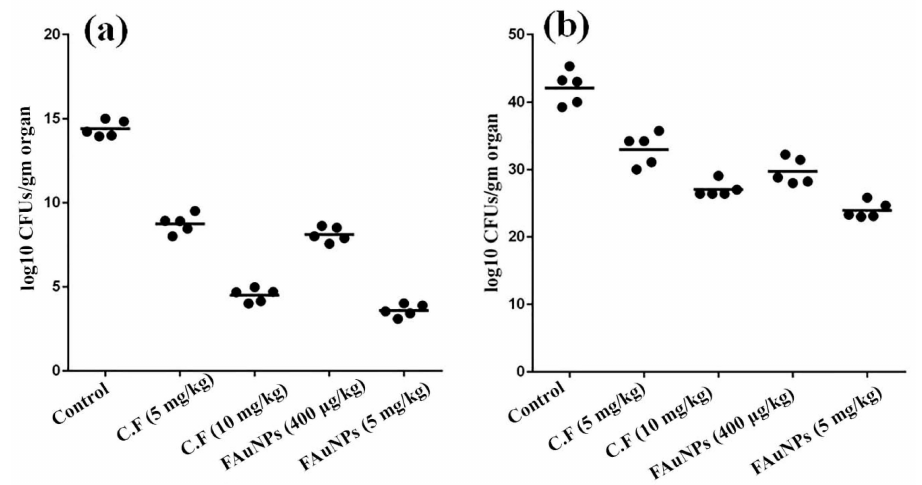
Figure 9. E ff ect of CF and FAuNPs, at respective MIC, on the colonization of E. faecalis in the kidneys ( a ) and liver ( b ) of